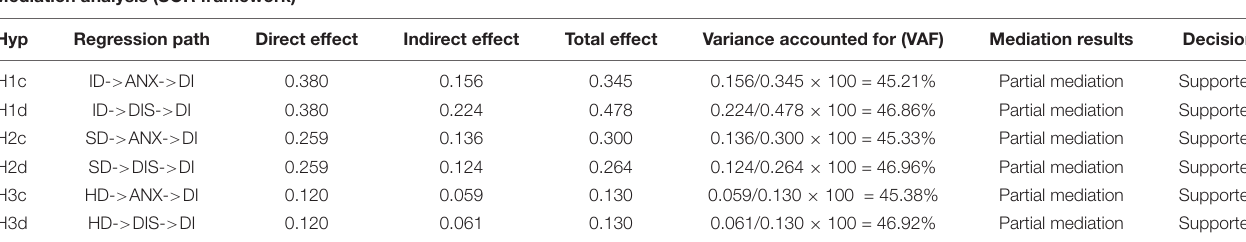
TABLE 7 | Mediation